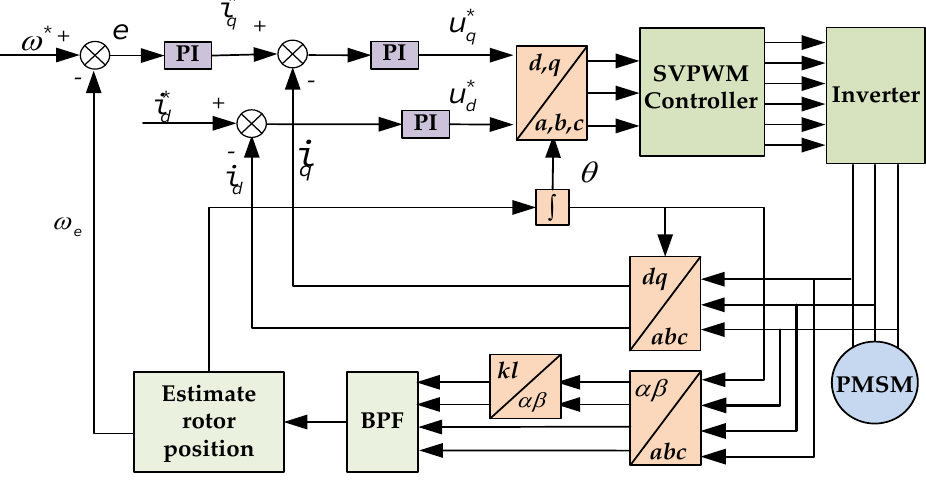
Figure 4. Block Diagram of the Carrier Frequency Component Method.